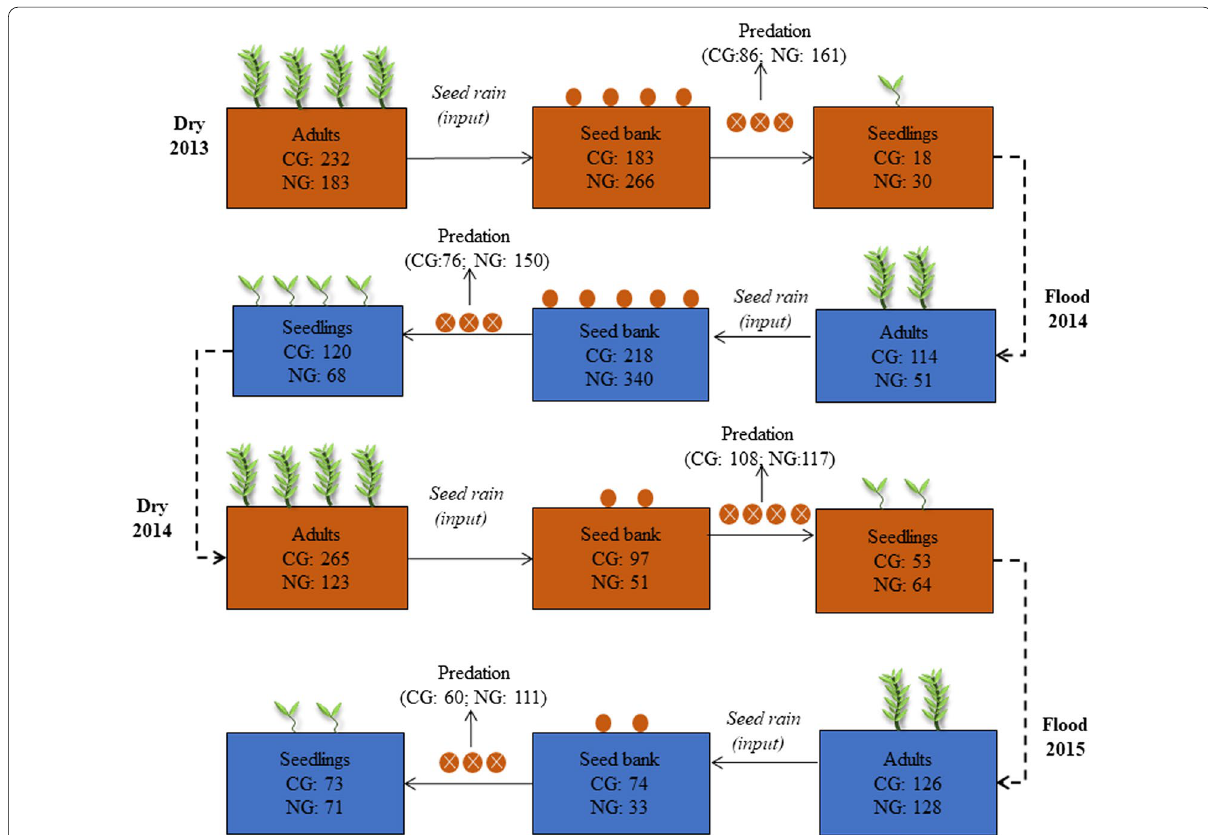
Fig. 1 General scheme of the abundance of adult plants, seed bank, predation seeds and seedlings in native (NG) and cultivated grasslands (CG) in flood and dry periods of the years (2013, 2014 and 2015) in the Pantanal wetland (Central-West